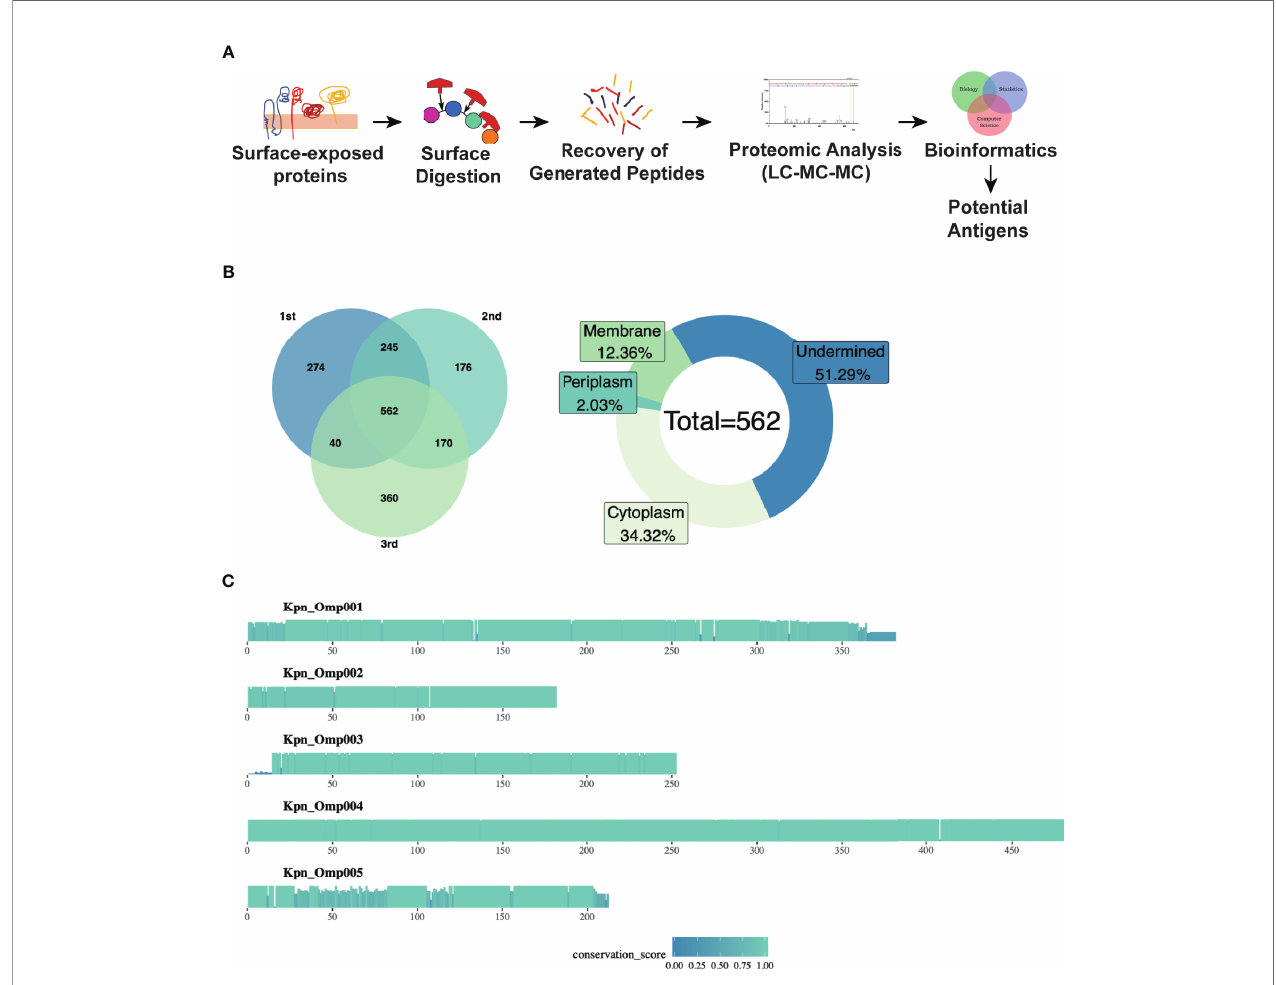
FIGURE 1 | Vaccine antigen gene analysis. (A) The work fl ow for selecting potential antigens combining proteomics with bioinformatics analysis. After “ shaving ” directly digested the surface protein, process the enzyme digested samples for LC-MS/MS to determine the cut-down proteins. Sequence conservation analysis predicted potential antigens. (B) Sequence conservation analysis. Comparing the genomic information of 389 Klebsiella pneumoniae strains obtained a conserved core gene database, which contains 562 proteins. The database was then analyzed from the structure information. The predicted surface proteins or secreted proteins were aligned with mass spectral data to exclude non-speci fi c mass spectral data, resulting in the most potential antigens. (C) Conservative analysis of KOMPs. The amino acid sequence of these KOMPs (Kpn_Omp001, Kpn_Omp002, Kpn_Omp003, Kpn_Omp004, and Kpn_Omp005) identity ranges from 96% to